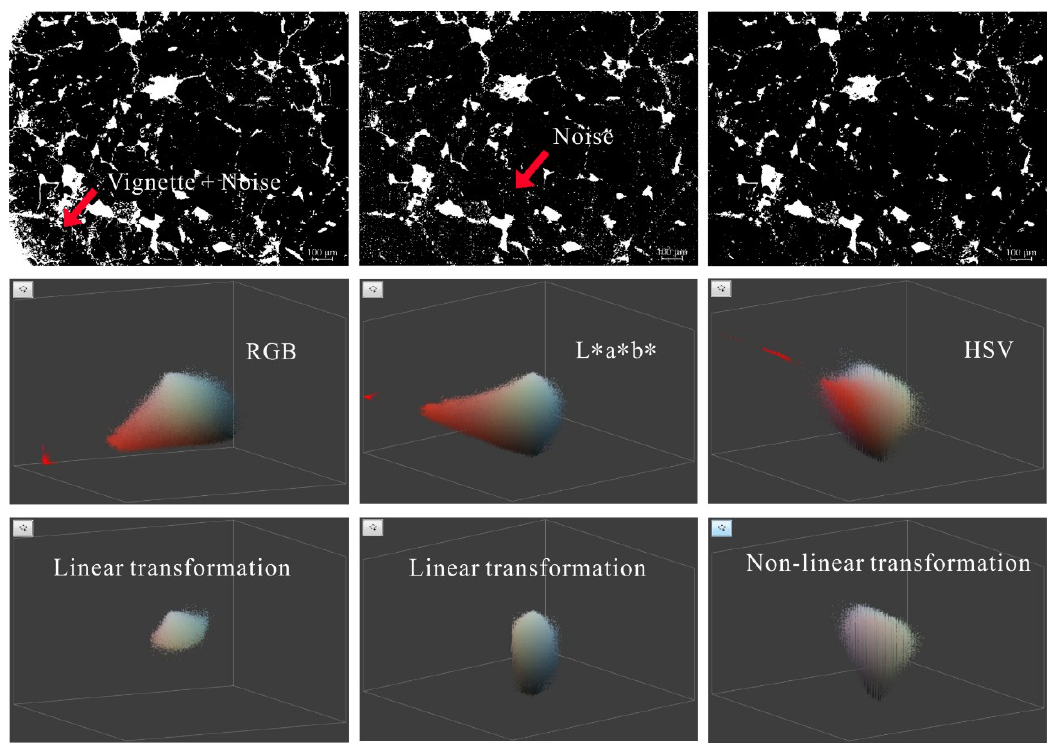
Figure 11. Color space changes before and after binary image processing.